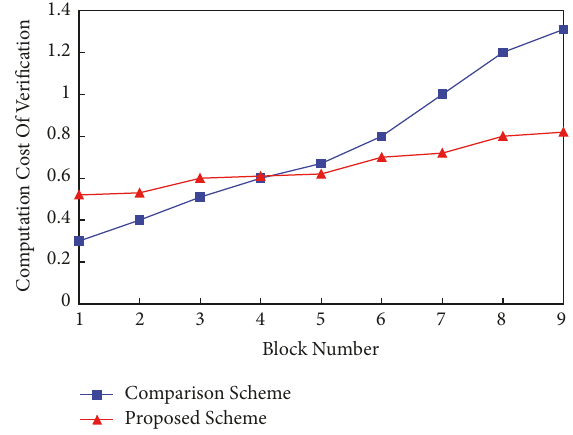
Figure 4: Tag generation computational cost.